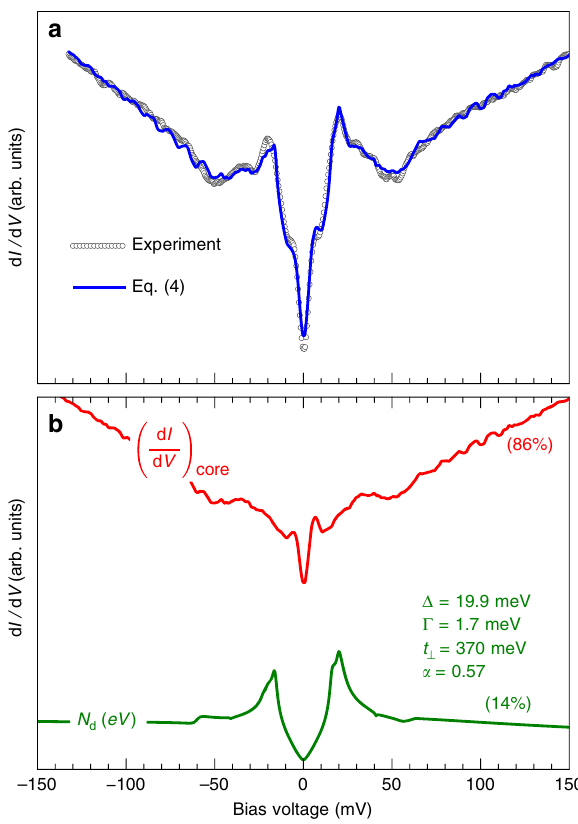
Figure 5 | Two-channel model for YBa 2 Cu 3 O 7 (cid:2) d . ( a ) Best fit (solid blue line) of the model (4) to the tunnelling spectrum of Y123 measured between vortices (dots). ( b ) Comparison of the coherent (green) and incoherent (red) contributions to the total spectrum. The numbers in parentheses give their relative contributions to the total spectral weight in the energy range of the